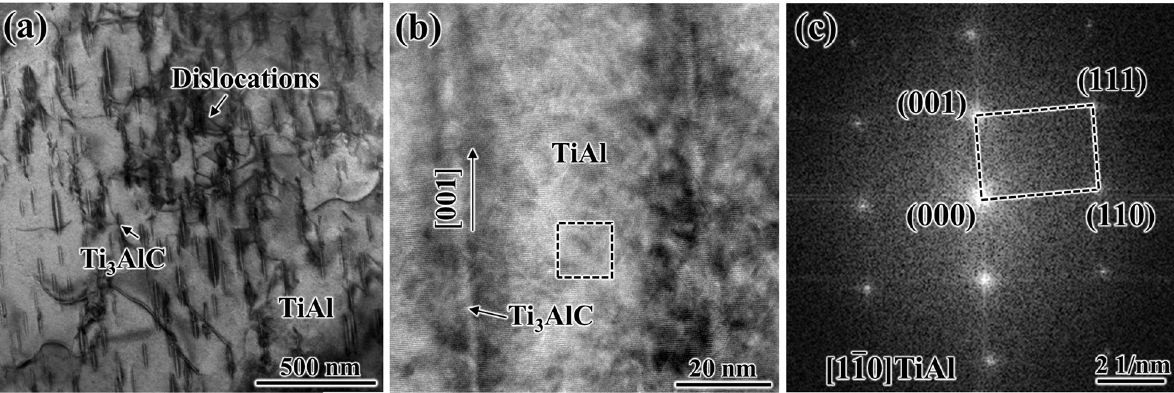
Figure 5: The TEM analysis of needle - like Ti 3 AlC nano - precipitates in TiAl alloys: ( a ) TEM image of needle - like Ti 3 AlC in TiAl; ( b ) HRTEM image of needle - like Ti 3 AlC in TiAl; ( c ) FFT pattern of TiAl.